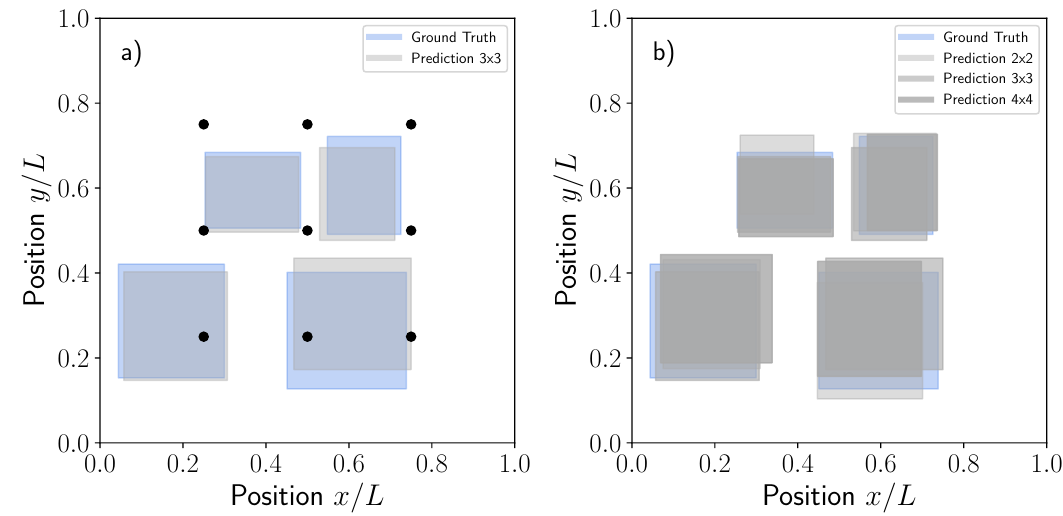
Figure 9. Comparisons between the ground truth and predictions for five randomly selected dissimilar material regions in terms of position and ( a ) size for the test data set using the 3 size, ( b ) Same results as previously shown but with different sensor network of 2